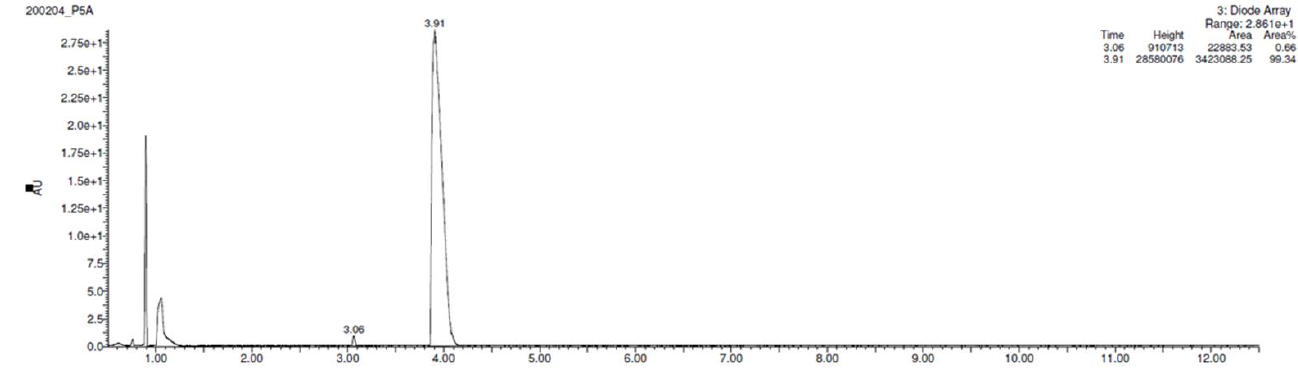
Figure 8. UPLC chromatogram of epinastine (EPI) and its degradation product in 0.1 M NaOH at 70 °C. As a result, alkaline degradation through opening of the imidazole ring in the EPI molecule with formation of the amide group was proposed (Table 4). The fragmentation pattern of the product EPI-DP1 is shown in Figure 9. Table 4. MS/MS results for epinastine (EPI) and its degradation product EPI-DP1 at 70 °C. Compound Structures